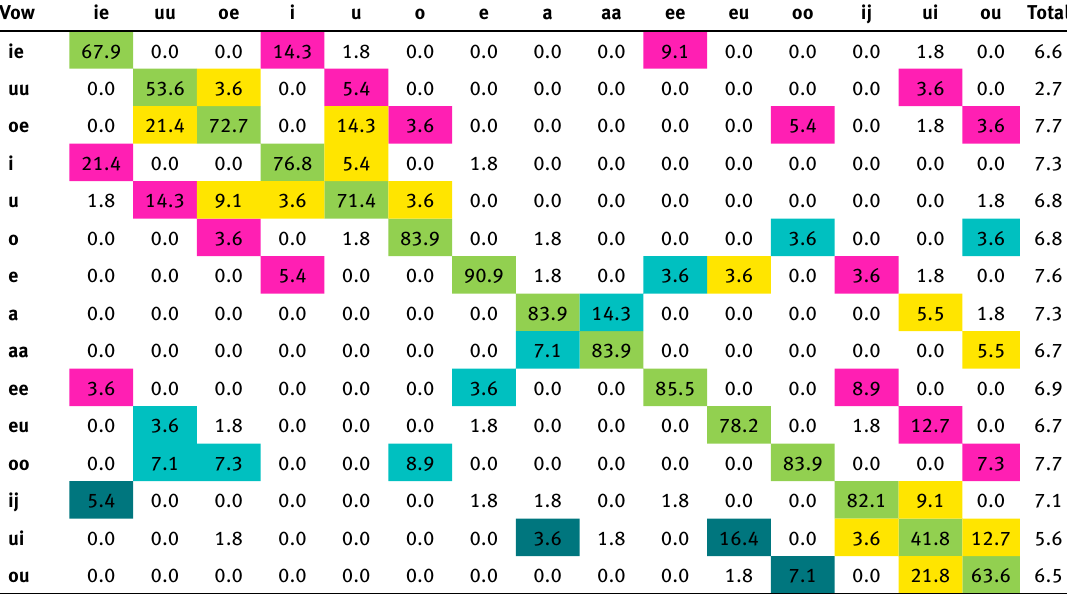
Table 6. Probability ratio of canonical (indicated in green) and non-canonical classifications for all 15 Dutch vowels produced by Spanish learners in the condition “Group” (F1, F2 + duration); target vowels in the columns, classified vowels in the rows, non-canonical classifications with deviations > 2.5% related to vowel height (in pink), vowel length (in turquoise), rounding (in yellow) and diphthongization (in teal) are also indicated; Vow = target